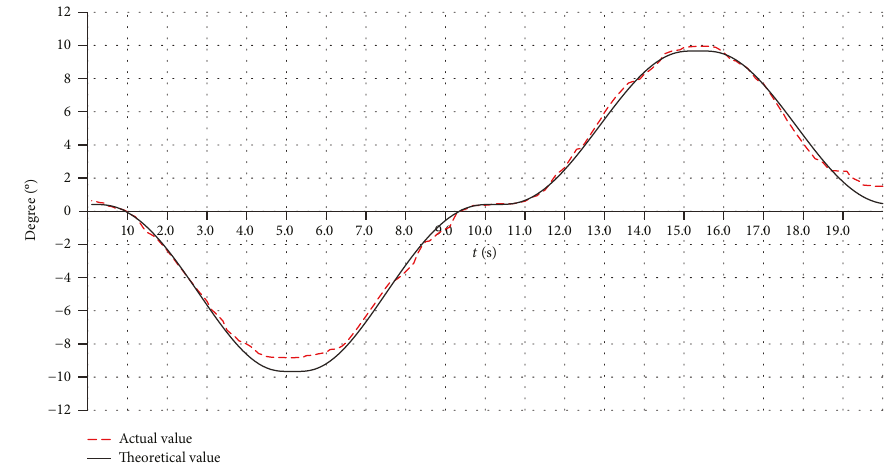
Figure 22: The working angles (from -10 ° to +10 ° ) for the varus/valgus rehabilitation motion.